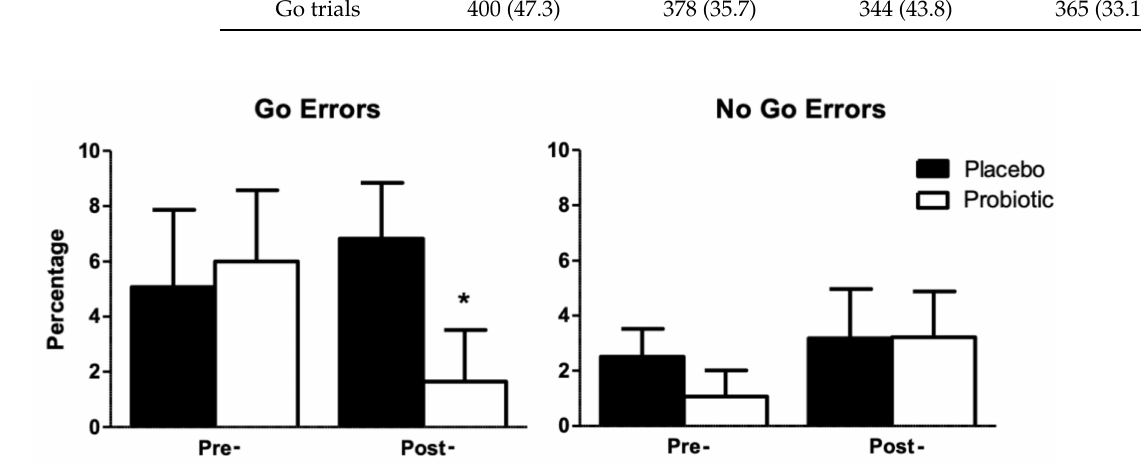
Figure 2. Percentage of omission errors (Go Errors) and of commission (No Go Errors) committed by participants in both groups depending on the treatment. Error bars represent the standard error of the mean. * marginal effect of the interaction group x